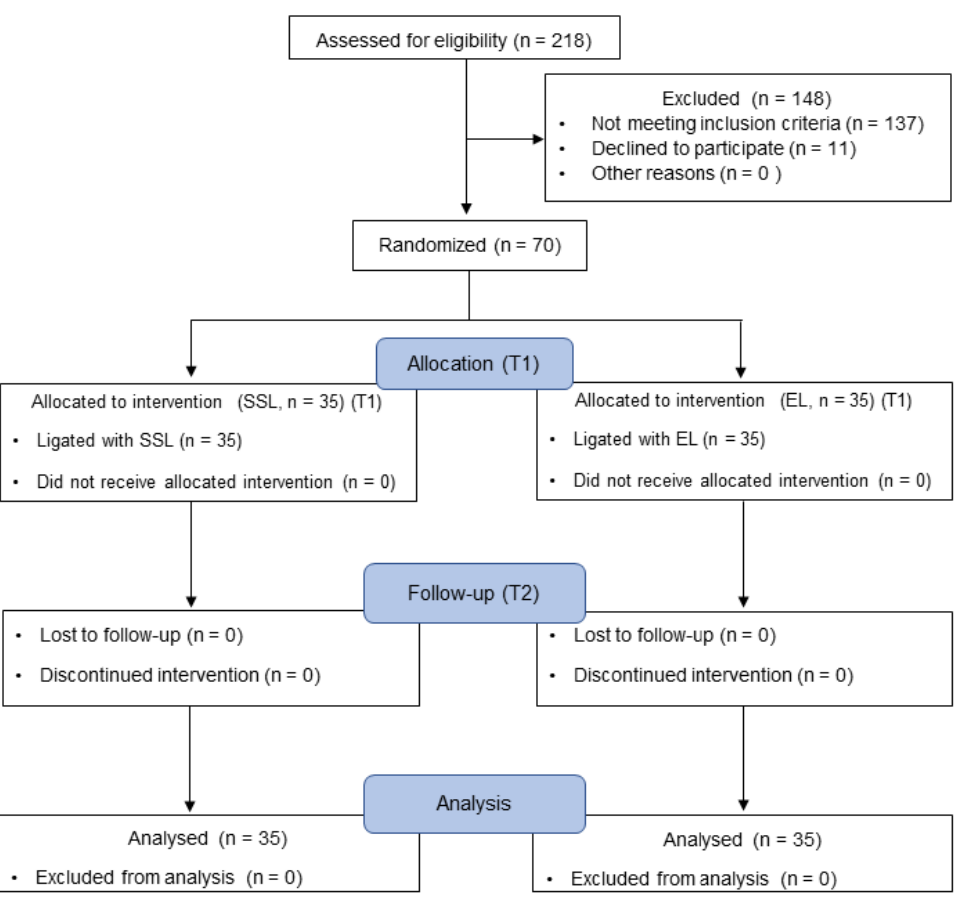
Figure 2. CONSORT flow diagram of the study participants. Table 1. Distribution of the sociodemographic, WSL, and dietary habit data based on ligature type at baseline.